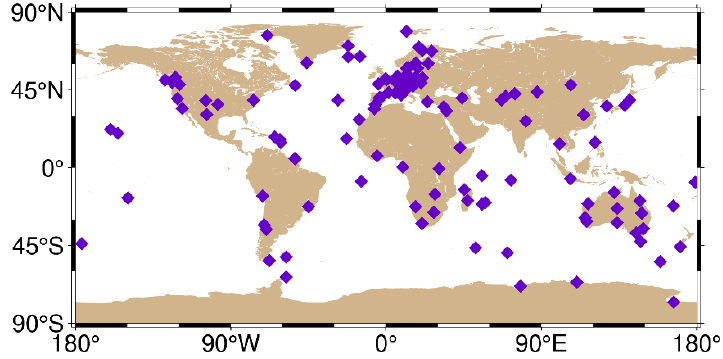
Figure 1. Geographical distribution of 145 tracking stations. Table 1. The strategy of SPP processing.